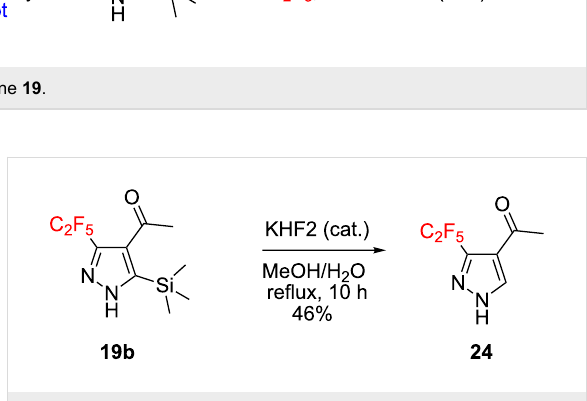
Scheme 2: Synthesis of 3,4-disubstituted pyrazole 24